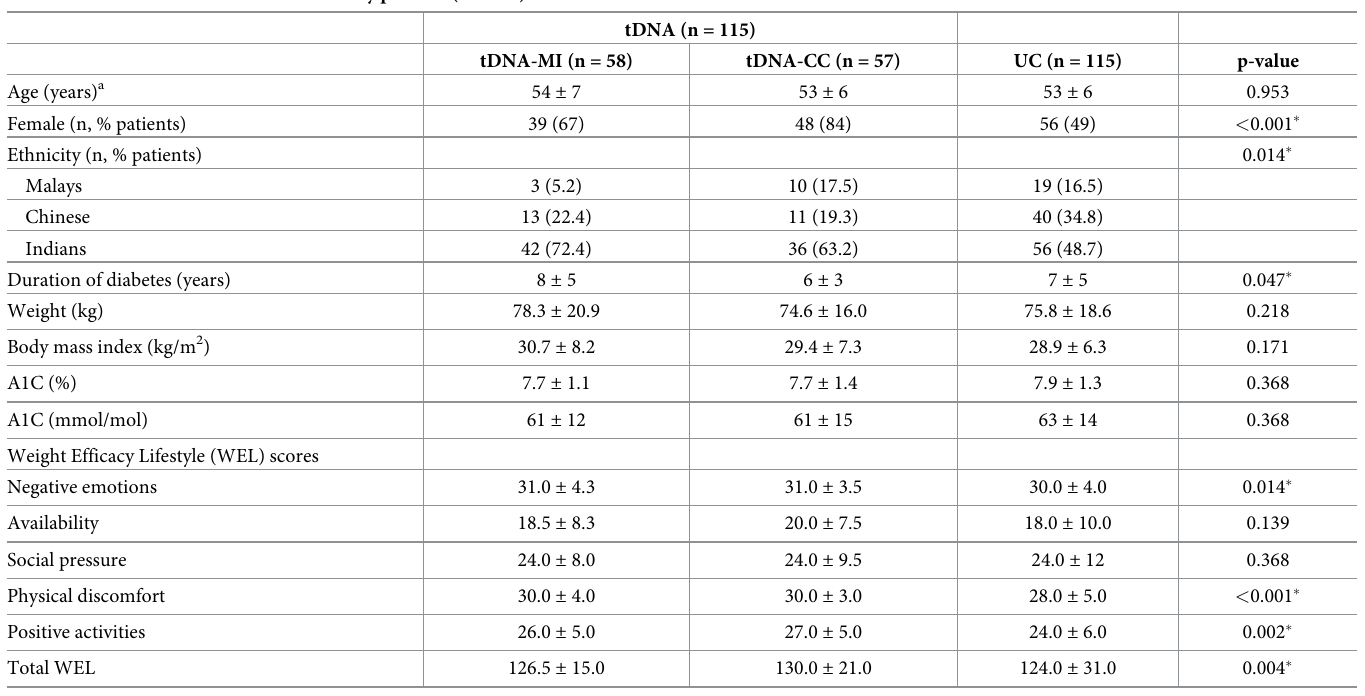
Table 2. Baseline characteristics of the study patients (n =